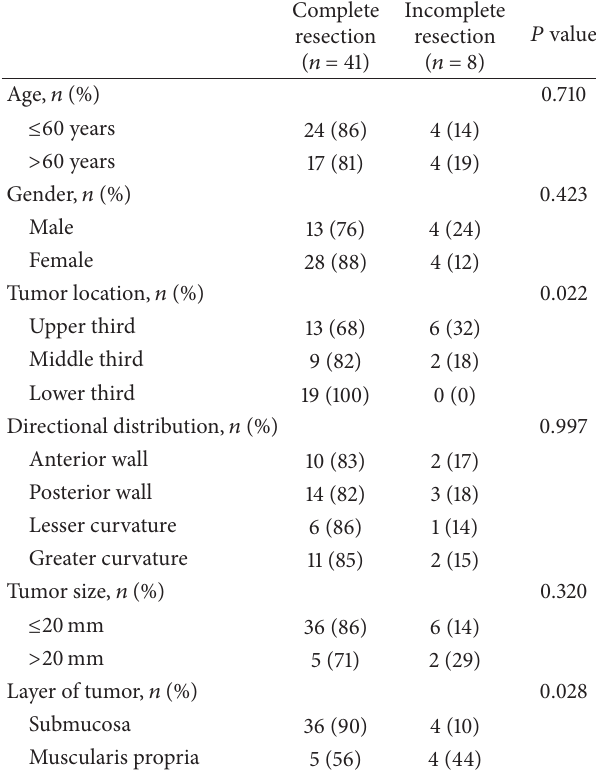
Table 3: Univariate analyses for predictive factors of incomplete resection with endoscopic submucosal dissection for gastric subep- ithelial